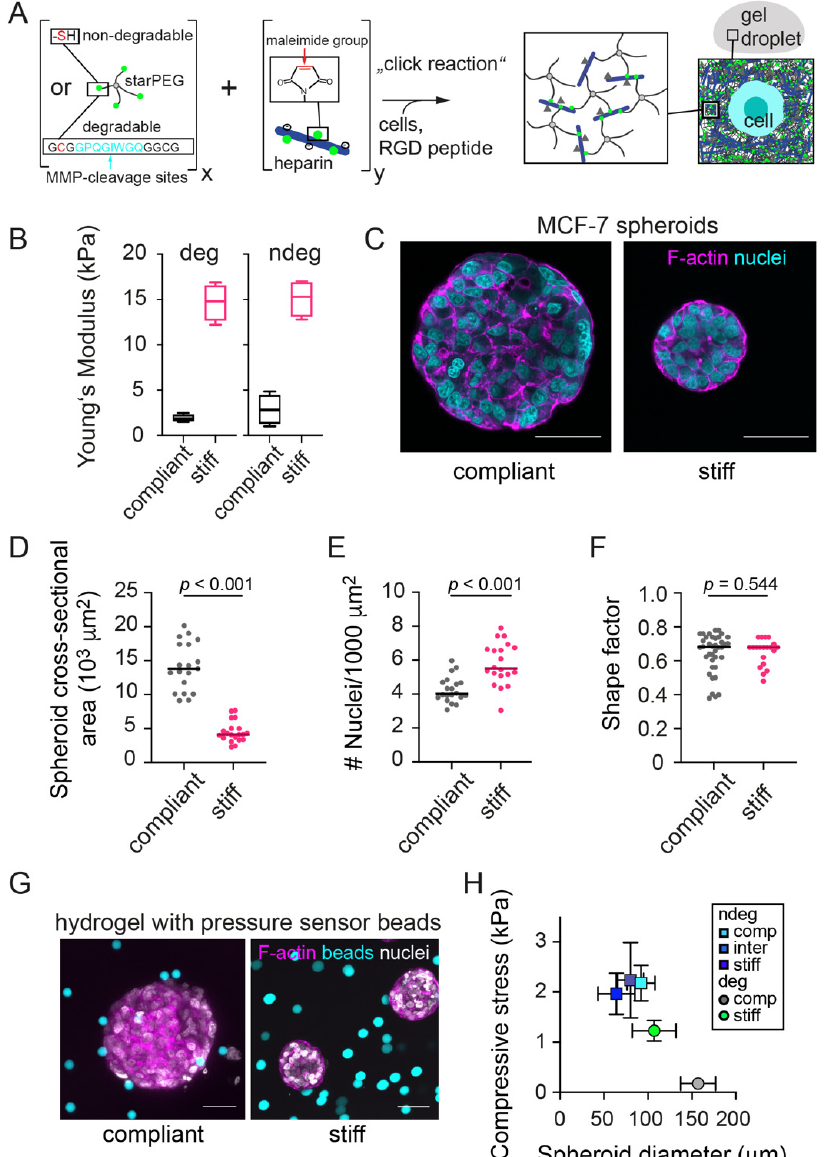
Figure 1. Hydrogel stiffness reduces the growth of MCF-7 spheroids. ( A ) Schematic of the PEG- heparin hydrogel system, into which initially single cells were embedded. ( B ) Elastic (Young’s) modulus for compliant and stiff hydrogels determined by AFM. n = 5–7 gels. ( C ) Representative confocal microscopy images of MCF-7 spheroids formed in a compliant and stiff degradable gel. Spheroid cultures were stained for F-actin and nuclei using Phalloidin-TRITC and DAPI respectively. Scatter plots showing ( D ) Cross-sectional area of MCF-7 spheroids in compliant and stiff degradable gels. Medians are indicated by a line. n = 20 spheroids each. ( E ) Number density of cells per unit area of cross-section of MCF-7 spheroids in compliant and stiff degradable hydrogels. n = 20 spheroids each. ( F ) Shape factors of tumor spheroids. ( D – F ) Shapes, sizes and densities were determined from confocal microscopy images of Phalloidin-TRITC/DAPI stained spheroid cultures using FIJI. A Mann–Whitney test was performed for statistical analysis ( p -values are given). Spheroids analyzed after 14 days of culture. ( G ) Representative confocal microscopy images of MCF-7 spheroids that had grown together with elastic polyacrylamide beads in a compliant and stiff degradable gel as described in [30]. Spheroid cultures were stained for F-actin and nuclei using Phalloidin-TRITC and DAPI respectively; beads were fluorescently conjugated. ( H ) Compressive stress estimated from bead deformations as a function of the final spheroid diameter reached on day 14. Means +/ − SEM are shown. All scale bars correspond to 50 µm.